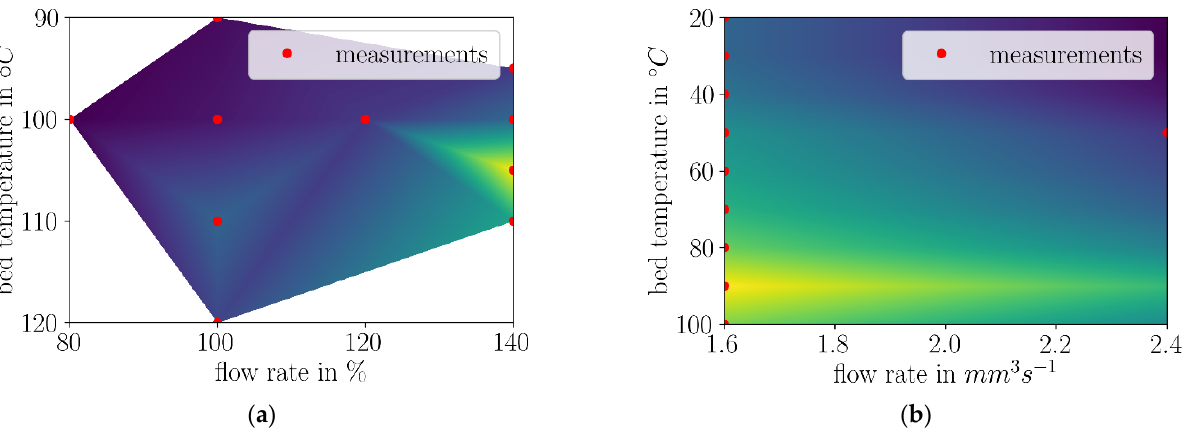
Figure 8. Simple synthetic data generation using measurements for the pretraining of the neural networks are shown: ( a ) linear interpolation using data from Kujawa [28] and ( b ) superposition using data from Spoerk et al. [27].